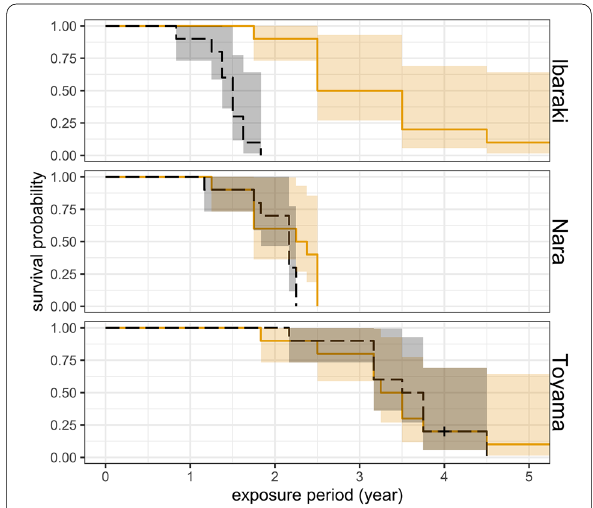
Fig. 5 Kaplan–Meier curves observed in Ced‑S and Ced‑H deterioration at different sites. Dashed line; Ced‑S, solid line; Ced‑H. Color‑coded areas indicate 95% confidence